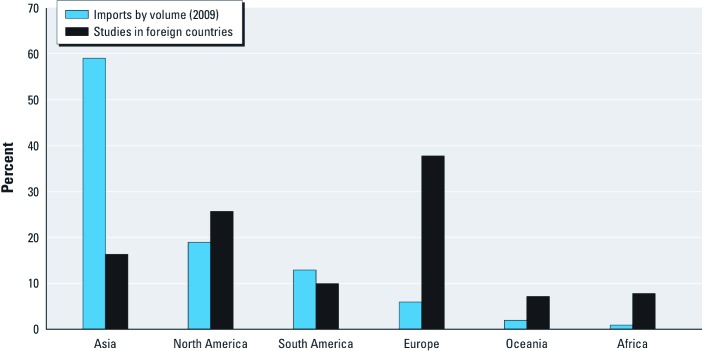
Comparison of the percentage of all seafood imports into the United States by volume in 2009 according to region (NMFS 2010) with the percentage of all non-U.S. studies in the Seafood Hg Database by region conducted in foreign countries. Studies from foreign countries exclude market basket studies, and percent imports do not account for re-exportation of imported fish.